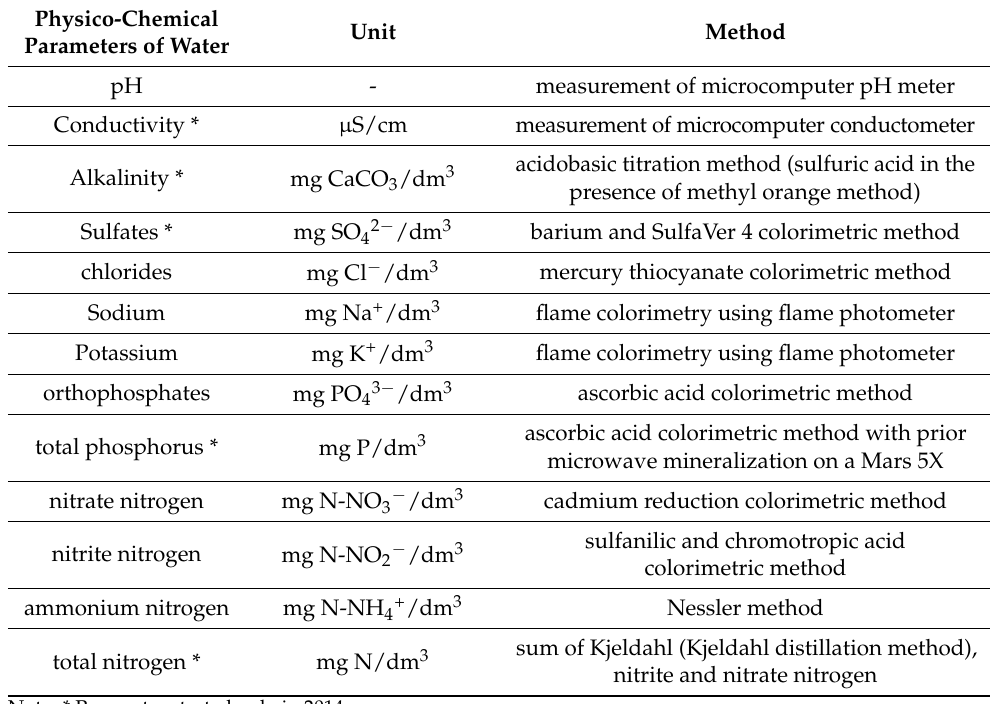
Table 1. List of physico-chemical parameters of water analyzed in the surveyed ponds. Physico-Chemical Unit Method Parameters of Water pH - Conductivity * acidobasic titration method (sulfuric acid in the presence of methyl orange method) Sulfates